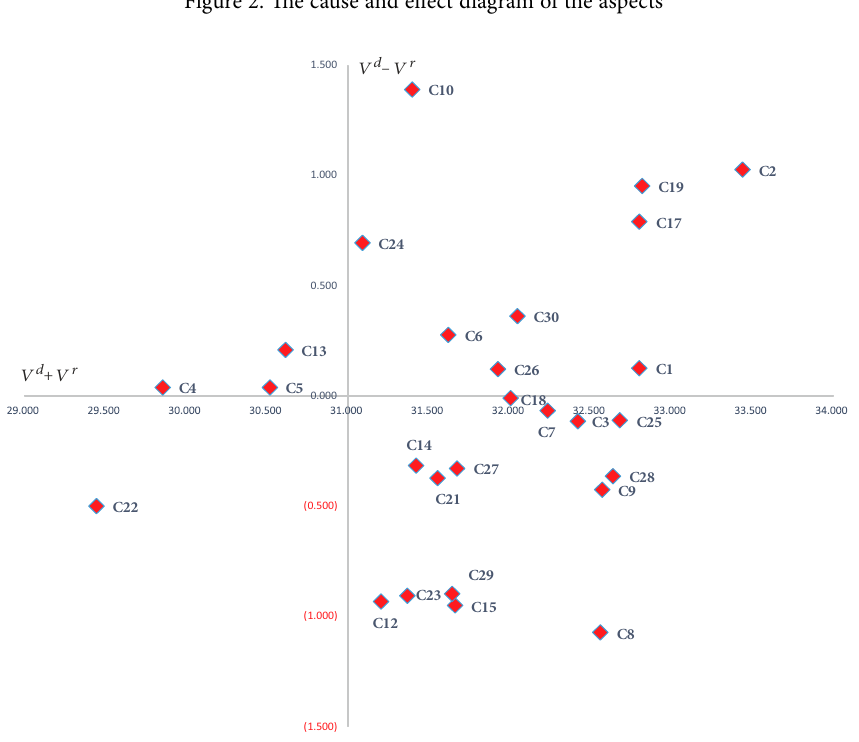
Figure 3. The cause and effect diagram of the SCP